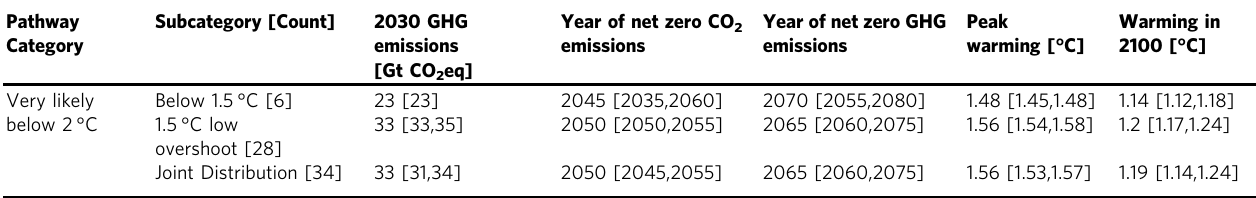
Table 3 Pathway characteristics of AR6 WG III pathways achieving the Paris Agreement